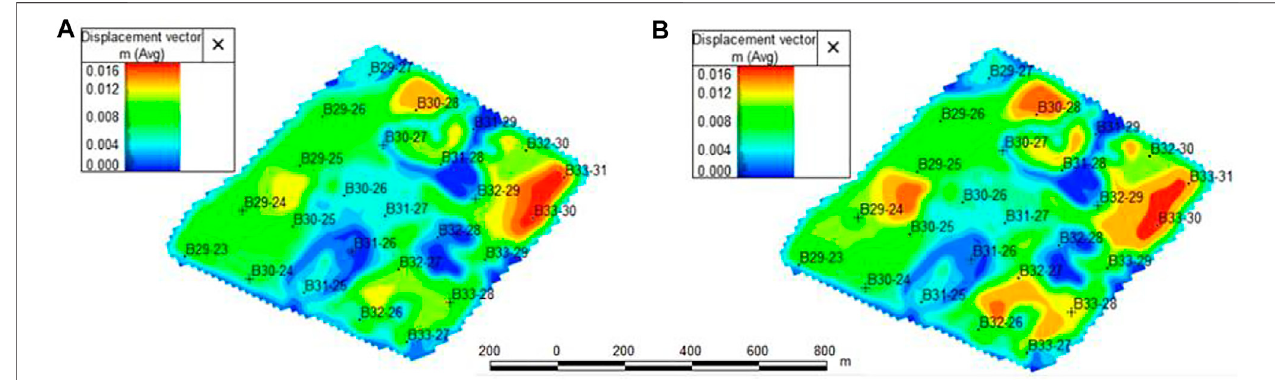
FIGURE 15 | Plane distribution of displacement vector of the target layer in the study area: (A) Only stress sensitive is considered, (B) Both starting pressure gradients and stress-sensitive effects are considered.